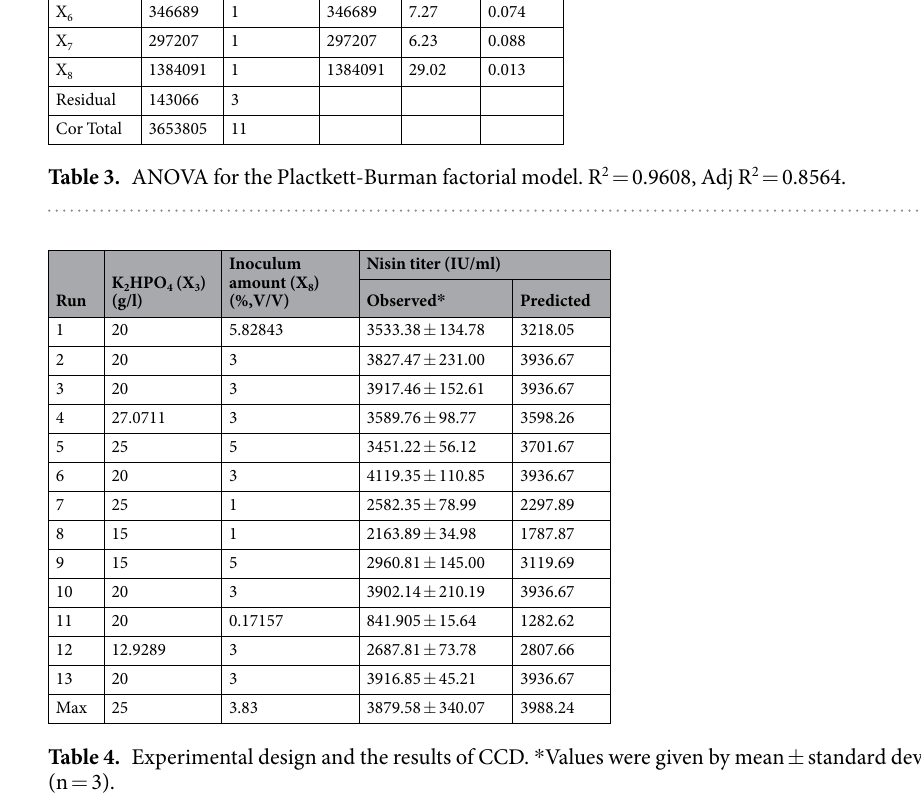
Table 4. Experimental design and the results of CCD. * Values were given by mean ± standard deviation (n = 3).